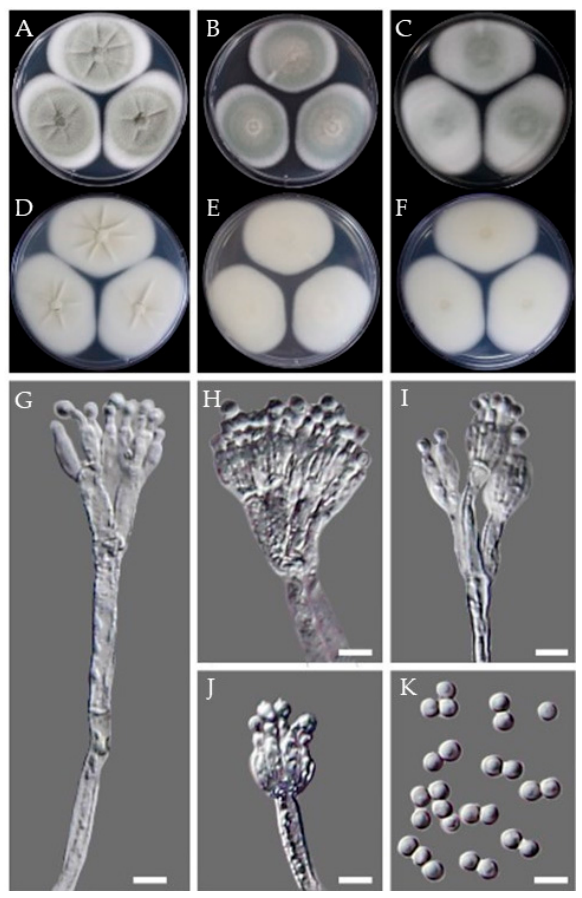
Figure 9. Morphological observations of the isolate CMML21–7. Obverse and reverse colony morphology on CYA ( A , D ), MEA ( B , E ), and YES ( C , F ) after 7 days at 25 °C. Structures and shapes of conidiophores including phialides, metulae, and stipes ( G – J ); conidia ( K ). Scale bars, ( G – K ) = 5 μ m.